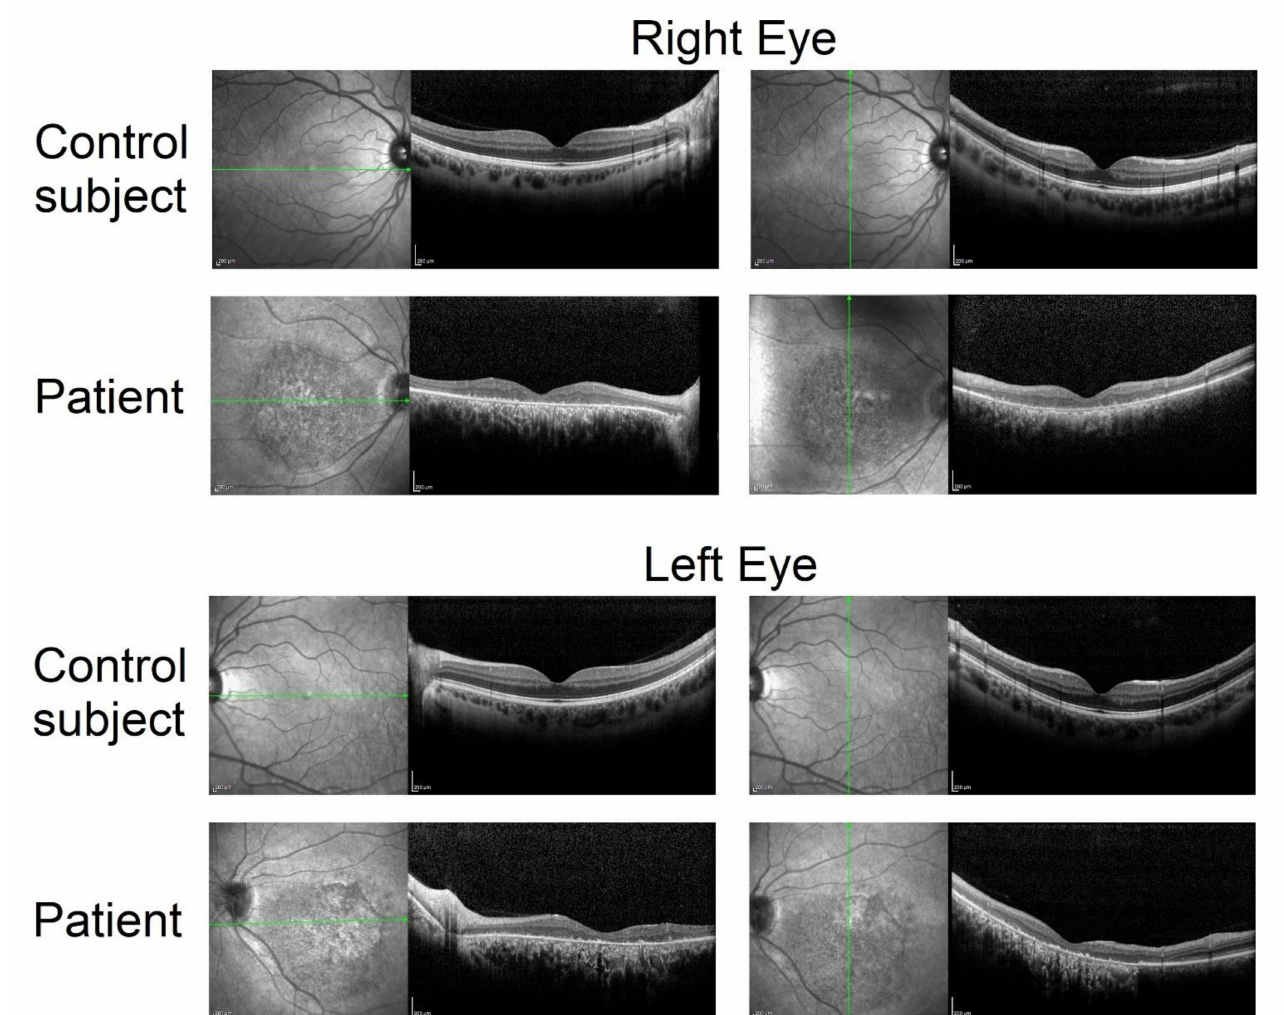
Figure 1. Fundus autofluorescence and optical coherence tomography recorded in the study patient (top rows) and in a healthy control (bottom rows). Green arrows represent the direction of OCT scan. Note the large area of atrophy in the central retina and the thinning of the outer nuclear layer. Scale bars = 200 µ